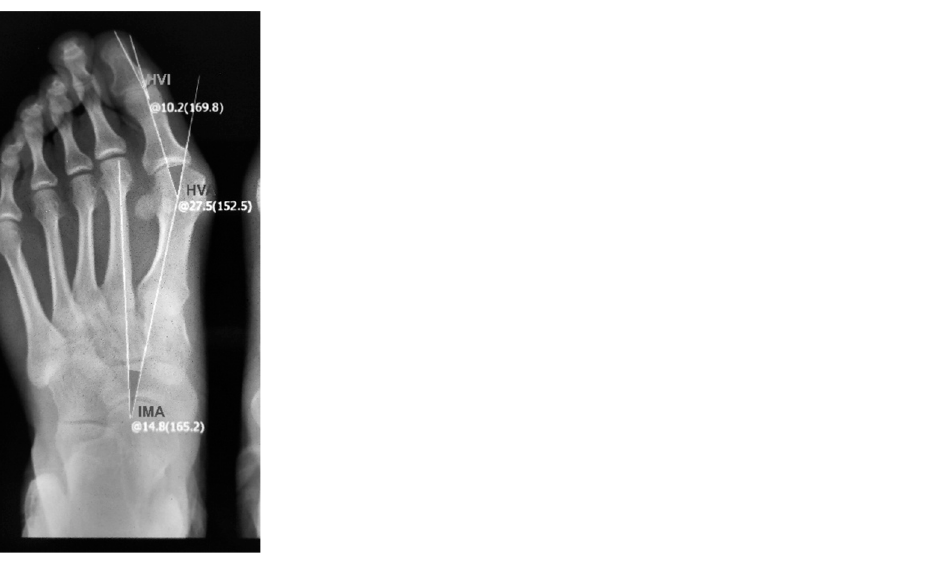
Figure 3. Radiograph of HV foot with radiographic parameters (HVA, IMA and HIA) captured by a radiographic scanner (Yuwell DR 60).